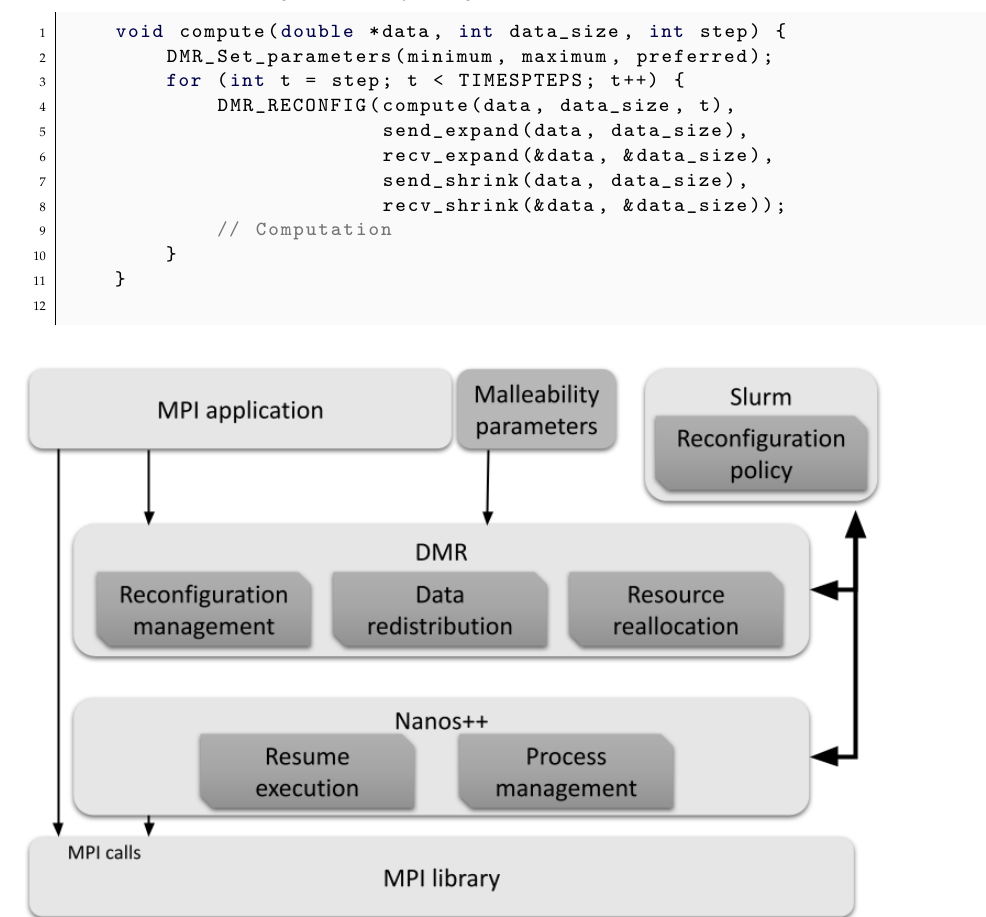
Figure 5. DMRlib